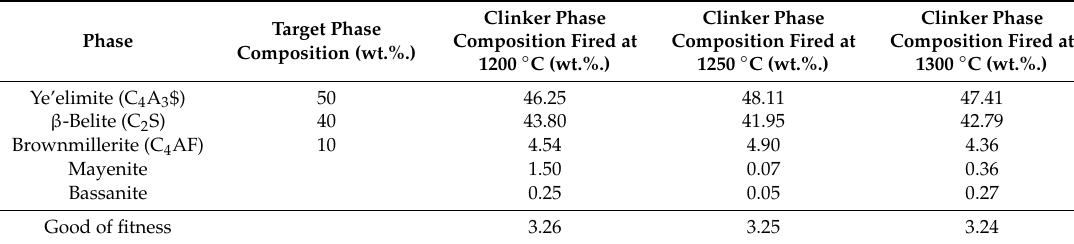
Table 3. Target phase composition of CSA clinker phase and CSA clinker phase composition fired at various temperatures calculated by Rietveld refinement technique.